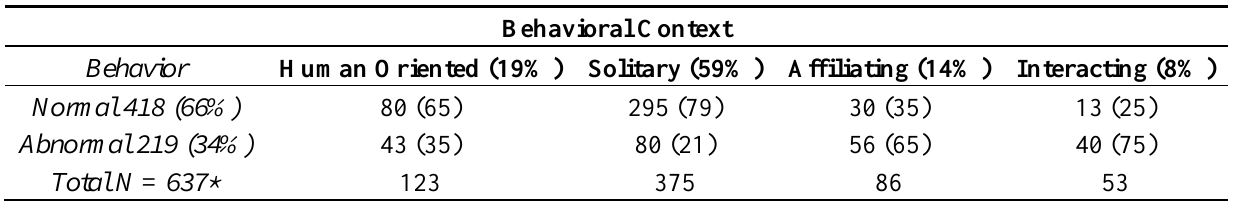
Table 2. Poco’s Distribution of Normal and Abnormal Behaviors in Each Behavioral